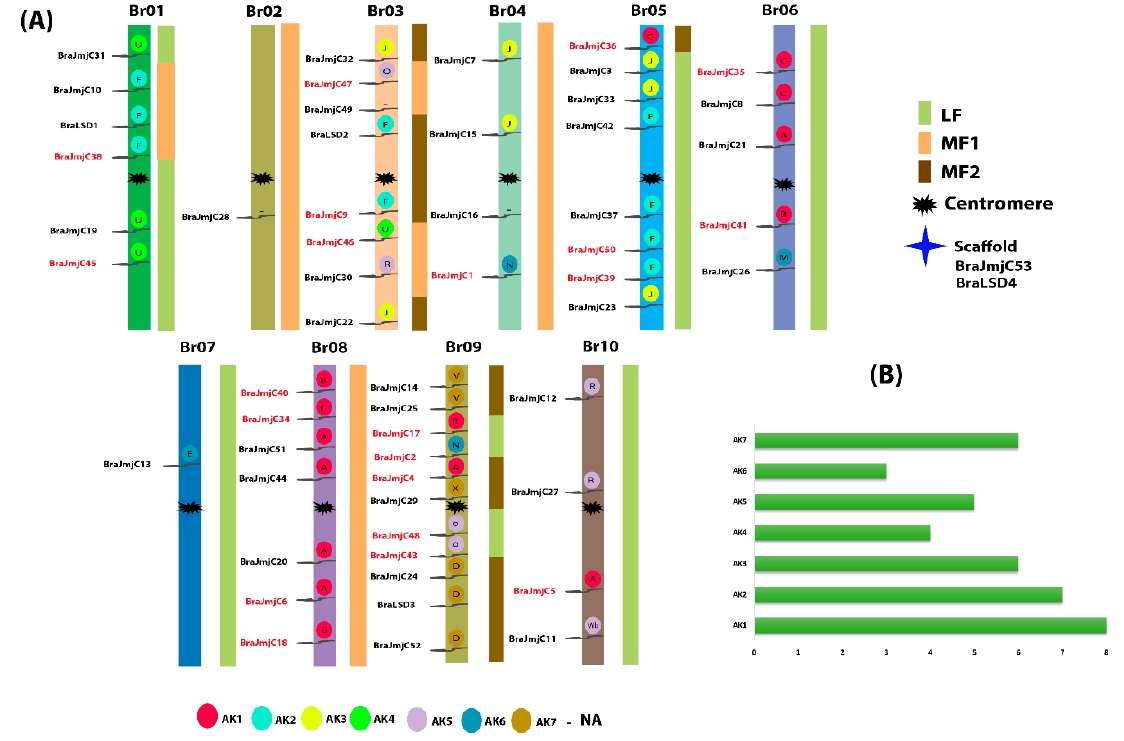
Figure 3. ( A ) Chromosome locations of JmjC were obtained from the GFF file and displayed using Mapchart. The paralogous pairs are displayed in red and while the three subgenomes (i.e., LF = Least fractionated, MF1 = Medium Fractionated and MF2 = Most Fractionated genome) of Brassica rapa are also visualized by di ff erent color. The ancestral karyotypes (i.e., AK1–AK7) are marked in di ff erent colors and the letters inside the circles represent the block positioned in the genome of B. rapa . ( B ) It represents the proportion of AK in B. rapa genome.